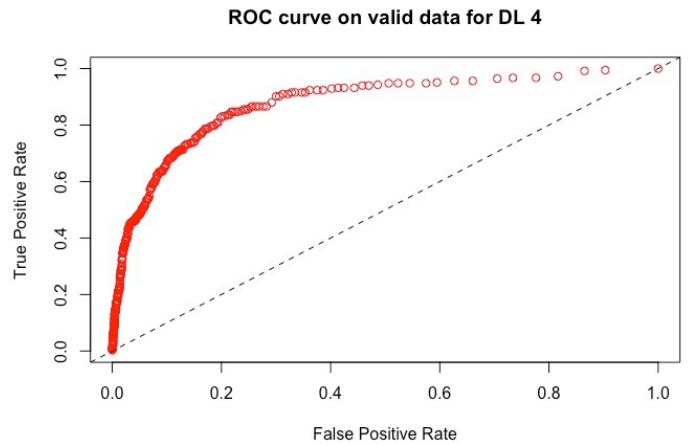
Figure 2. ROC curve for the model D4 using 181 variables using the validation